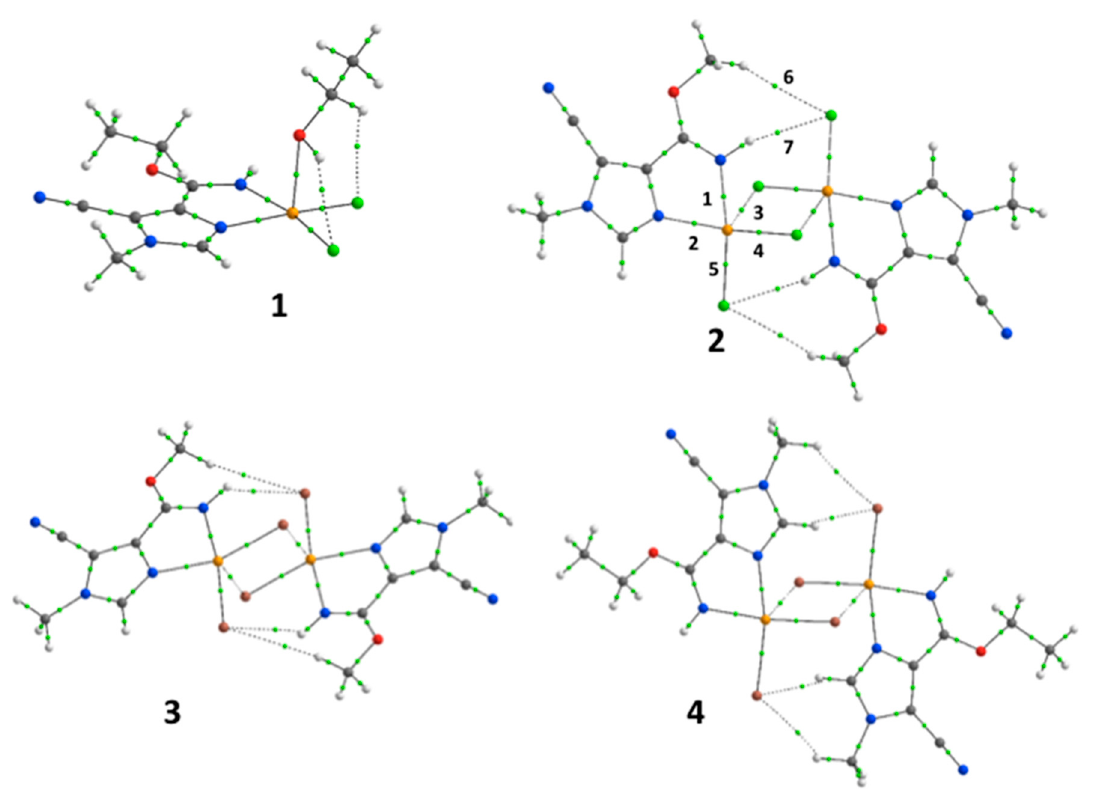
Figure 3. Bond paths and bond critical points (BCPs) in the copper compounds 1 – 4 according to QTAIM (Quantum Theory of Atoms in Molecules) analysis. Compound 2 shows the numbering of the BCPs, which is used in Table 3 for all compounds. For the color scheme of the atoms, see Figure 1.